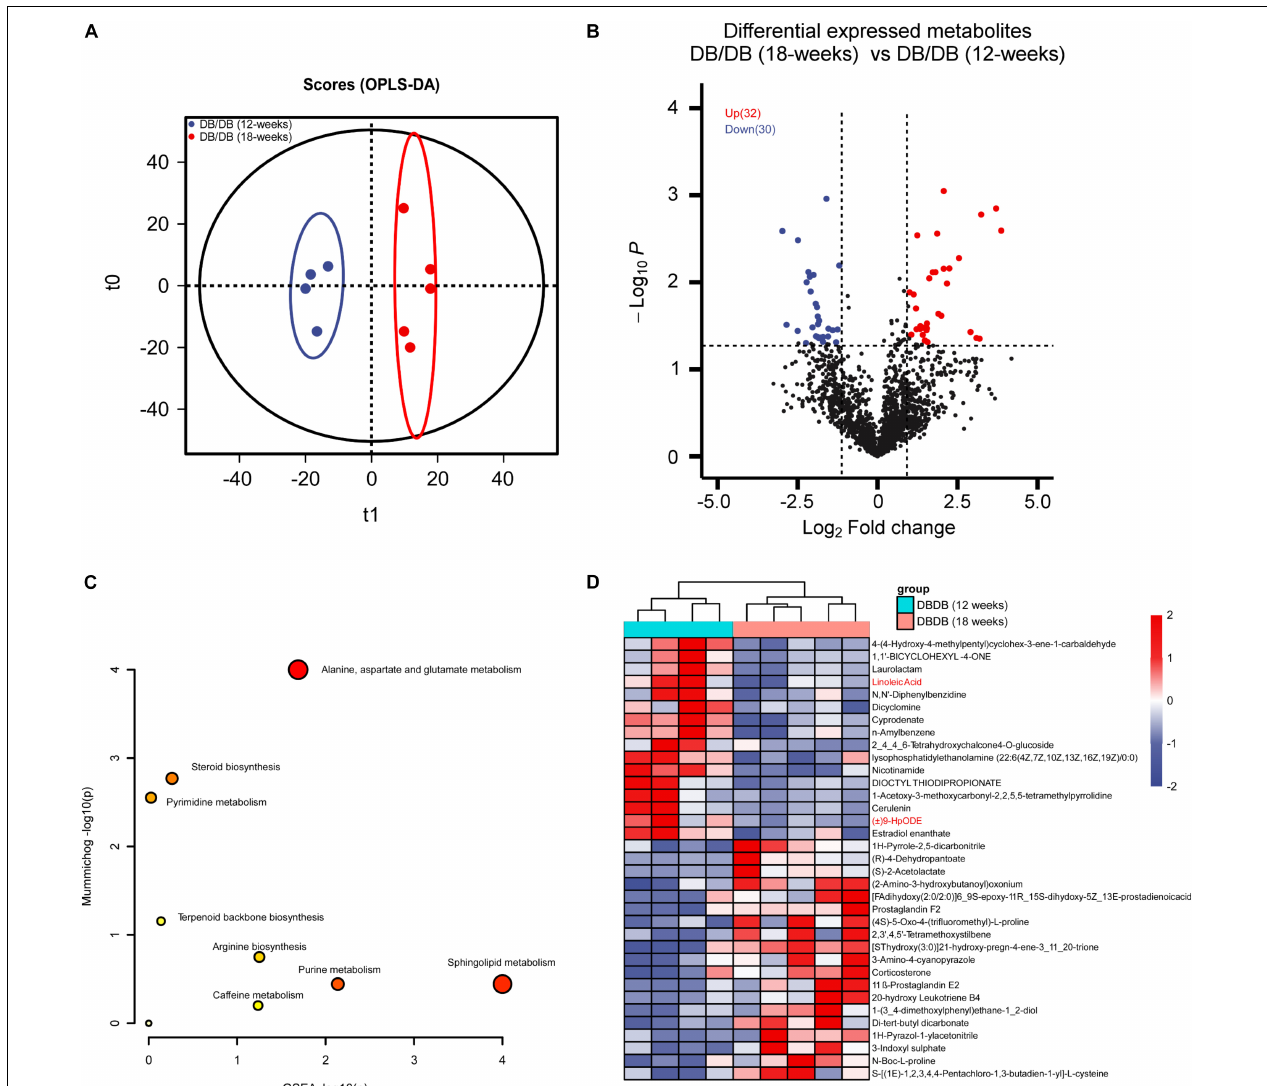
FIGURE 5 | Metabolomics analysis between kidneys of early stage DN and advanced-stage DN mice. (A) OPLS-DA plots of the metabolites detected in kidneys of early stage DN and advanced-stage DN mice (12 weeks db/db, n = 4; 18 weeks db/db, n = 5). (B) Volcano plot showing the DEMs between kidneys of early stage DN and advanced-stage DN mice. (C) The bubble plot showing the enriched KEGG pathways of DEMs between kidneys of early stage DN and advanced-stage DN mice. (D) The heatmap illustrating the levels of DEMs in kidneys of early stage DN and advanced-stage DN mice, each row represents one protein, each column represents one